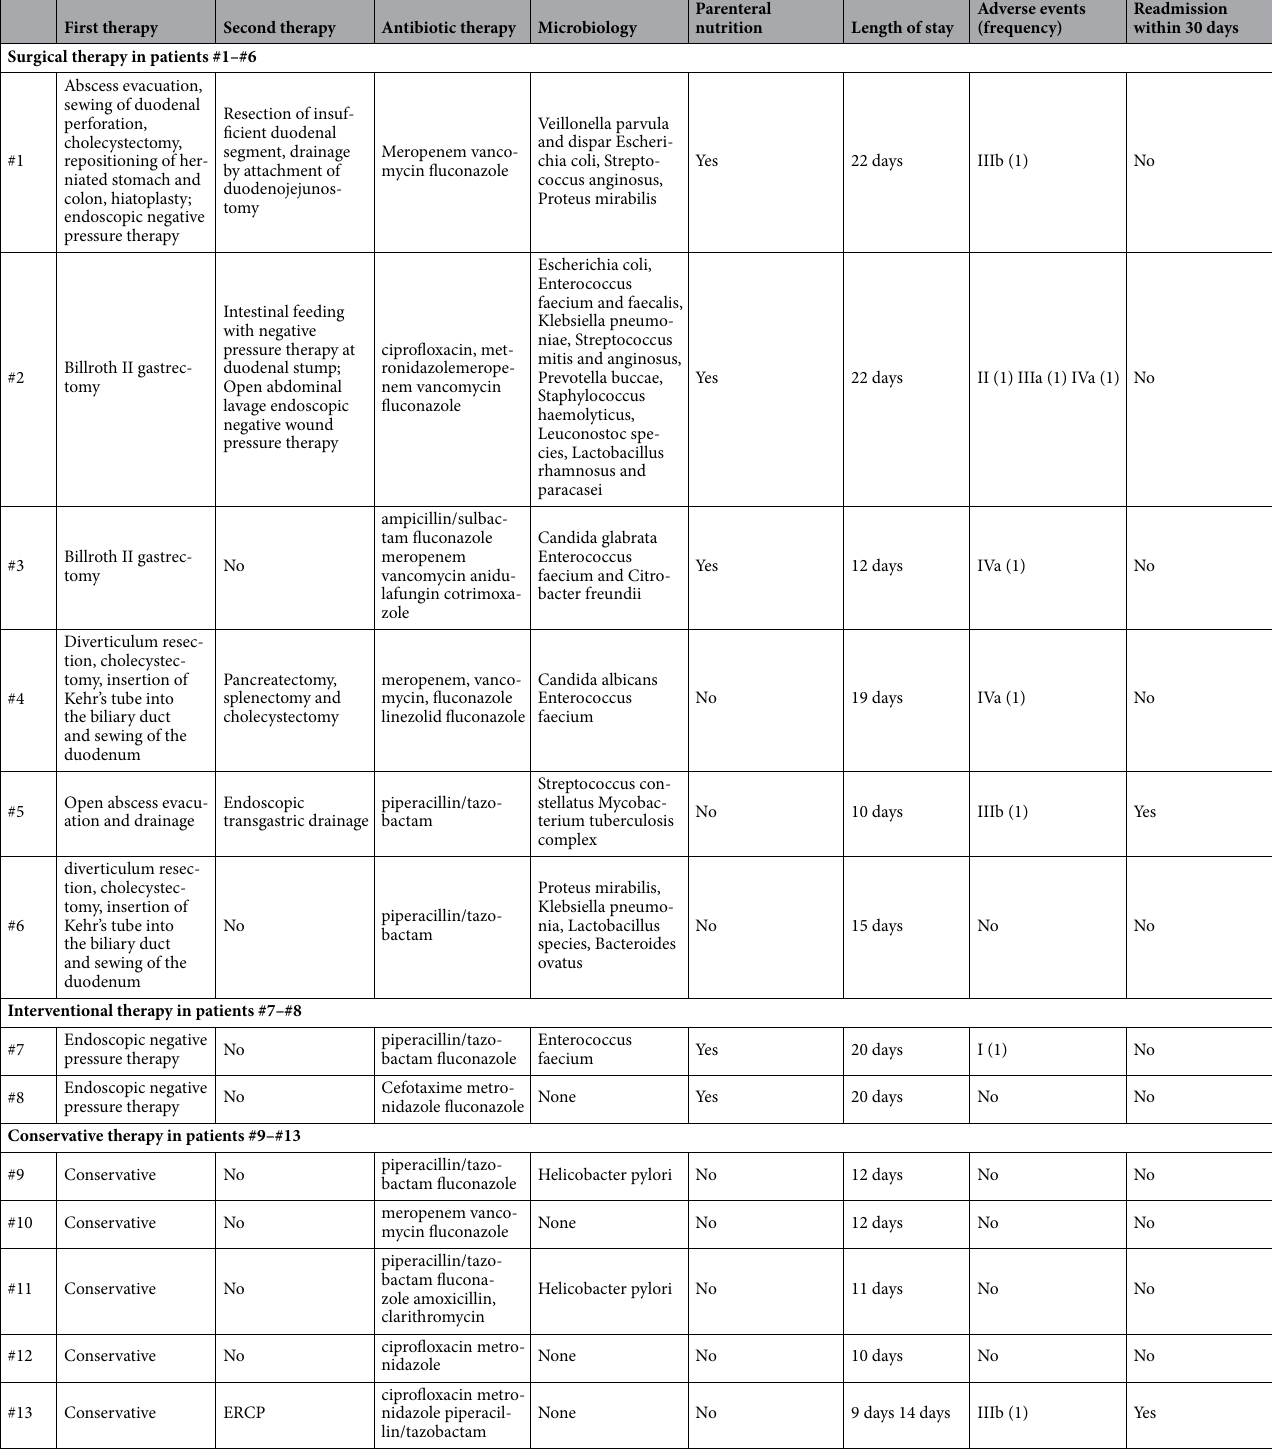
Table 3. Description of therapy and treatment failure, antibiotic therapy, microbiological findings, length of stay, adverse epvents according to Clavien-Dindo classification and